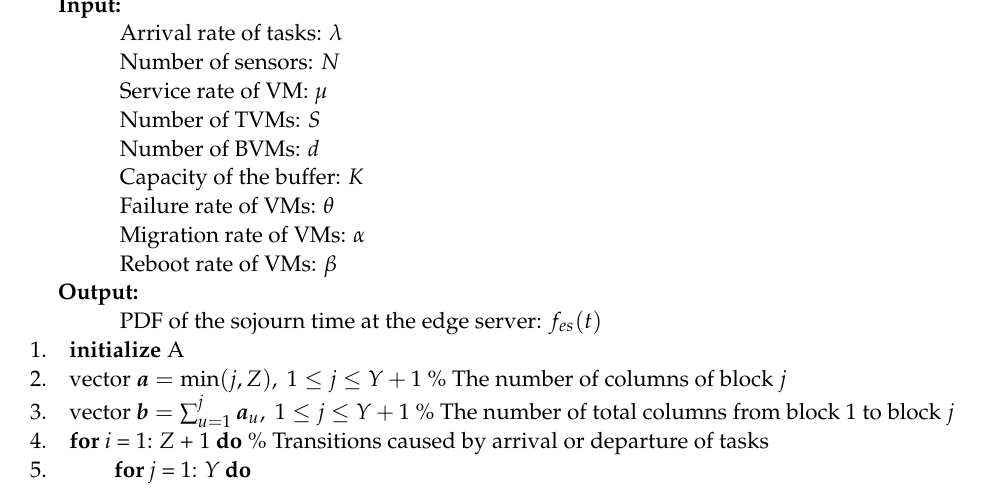
Algorithm 1 Algorithm for obtaining PDF of the sojourn time at the edge